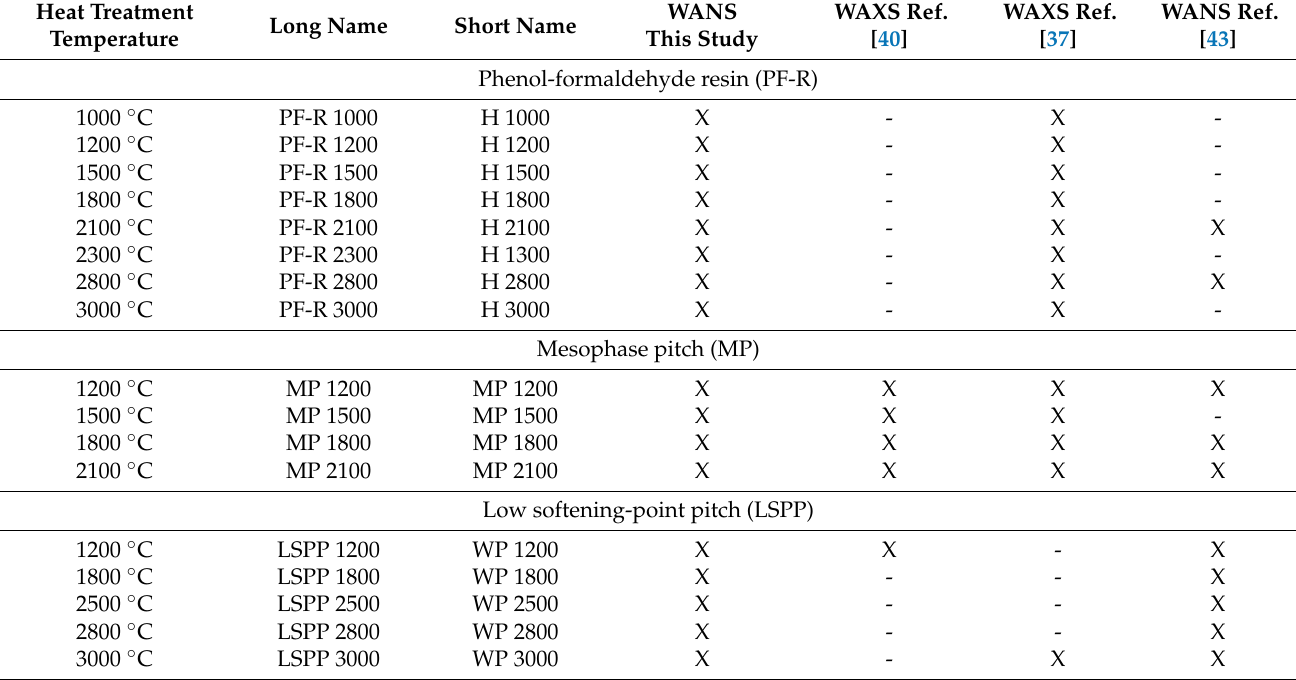
Table 1. Overview of the refinement of simulated WAXS data, which were blurred by statistical noise generated by a Gaussian distribution. The results indicate that OctCarb can evaluate reproducibly microstructural parameters from given WAXS and WANS data. Since the influence of σ 1 on WAXS (for typical Cu-K α lab setups) and the influence of σ 3 on WANS data is small, these parameters cannot always be determined exactly. Therefore, the resulting values for σ 1 (WAXS) and σ 3 (WANS) deviated significantly from the input